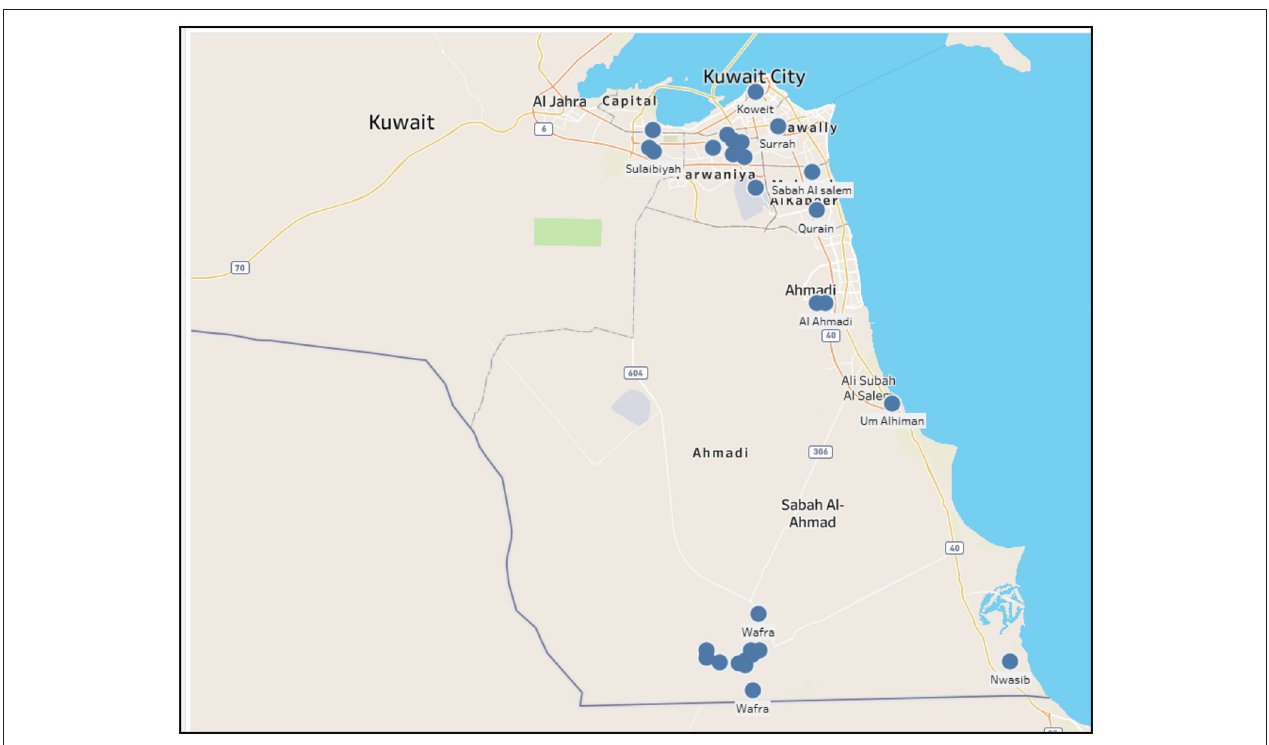
FIGURE 3 | Highly pathogenic avian influenza outbreaks in Kuwait during the period 2005–2020.